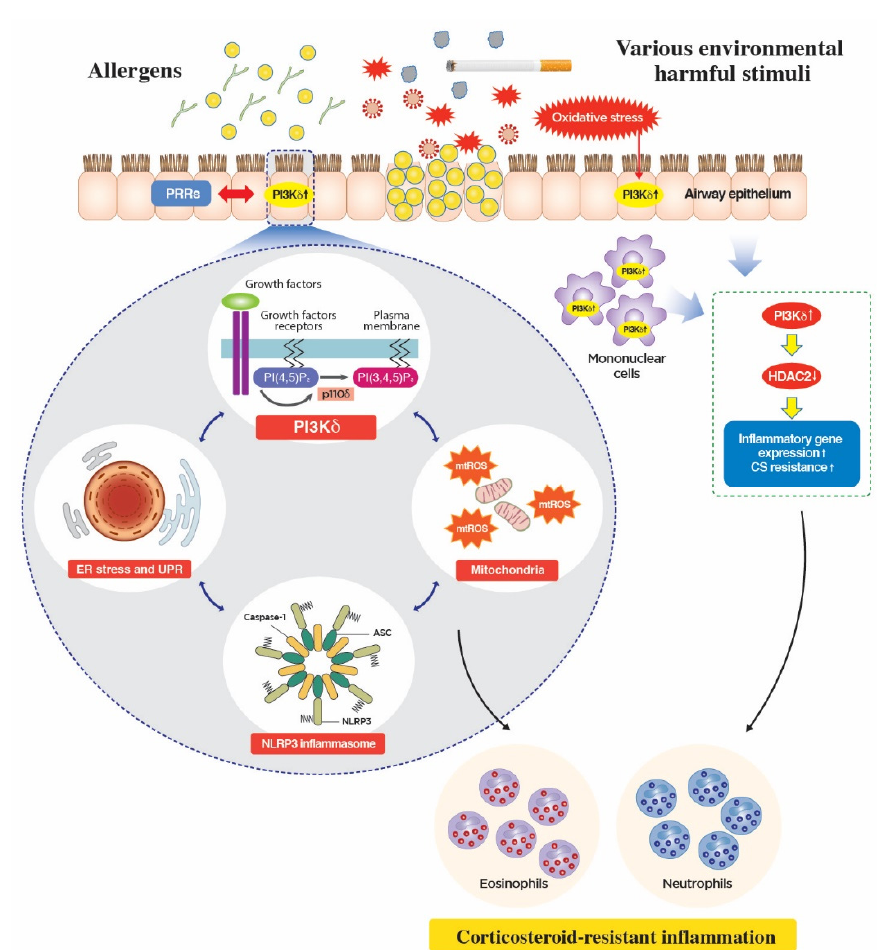
Figure 2. Mechanism of action of phosphoinositide 3-kinase- δ (PI3K- δ ) in corticosteroid (CS)-resistant lung inflammation. Airway epithelial cell express pattern-recognition receptors (PRRs) that can be activated directly by allergens such as fungus. PI3K- δ can be closely associated with PRR signaling pathways, and the activation of PI3K- δ in airway epithelium results in oxidative stress, mainly from mitochondria (mitochondrial reactive oxygen species; mtROS). Airway epithelial activation of PI3K- δ has also been known to regulate endoplasmic reticulum (ER) stress and NLRP3 inflammasome, both of which are well-known inducers of CS resistant lung inflammation, partly through modulation of mtROS. These PI3K- δ -associated cytoplasmic molecular platforms involving ER, mitochondria, and NLRP3 inflammasome represent a novel mechanism for the involvement of PI3K- δ in the pathogenesis of CS-resistant severe eosinophilic inflammation. Meanwhile, in response to a wide array of harmful stimuli (e.g., exposure to air pollutants, cigarette smoke, and direct injuries), PI3K- δ can be closely associated with oxidative stress, especially in the airway epithelial interface. Subsequent activation of PI3K- δ in airway epithelial cells and mononuclear cells leads to the reduction of histone deacetylase 2 (HDAC2), a key molecule in the suppression of pro-inflammatory cytokine production in these cells, thereby inducing CS-resistant neutrophilic inflammation and further oxidative stress in the lung. IL-17 has been reported to reduce HDAC activity and CS sensitivity in epithelial cells (not shown